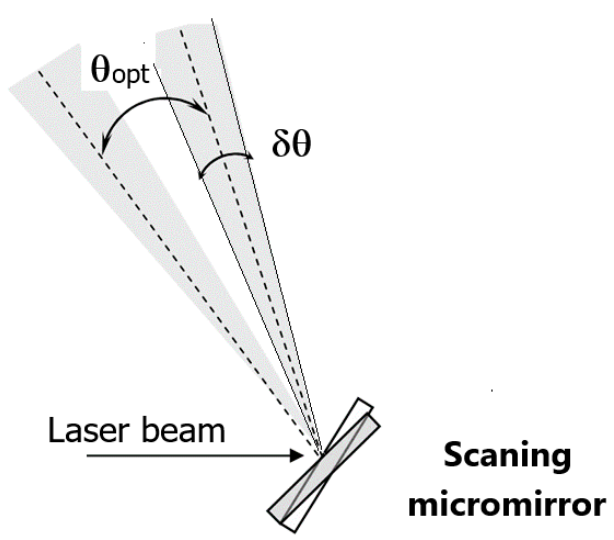
Figure 2. Total optical scan range of a scanning micromirror vs. the beam divergence.